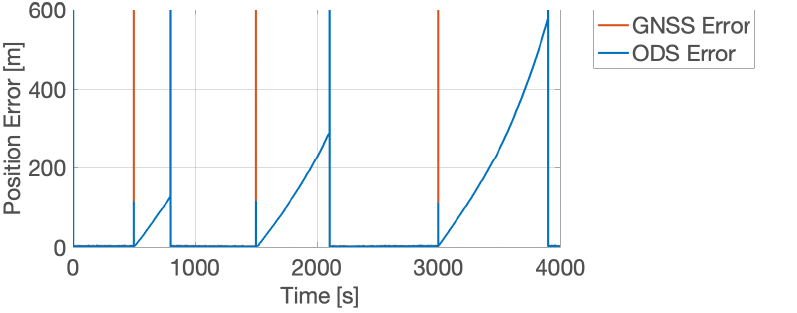
Figure 9. Attitude error in MIL analysis of Sun pointing AODS, with multiple injected failures. Gyroscopes loss at t (cid:39) 4000s. Primary magnetometer loss at t (cid:39) 11,000 s. Sun sensors loss at t (cid:39) 18,000 s .